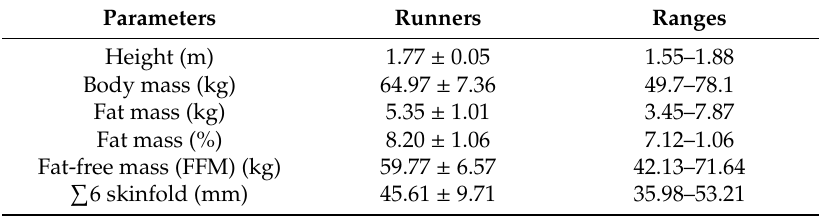
Table 1. Anthropometric and body composition values in the